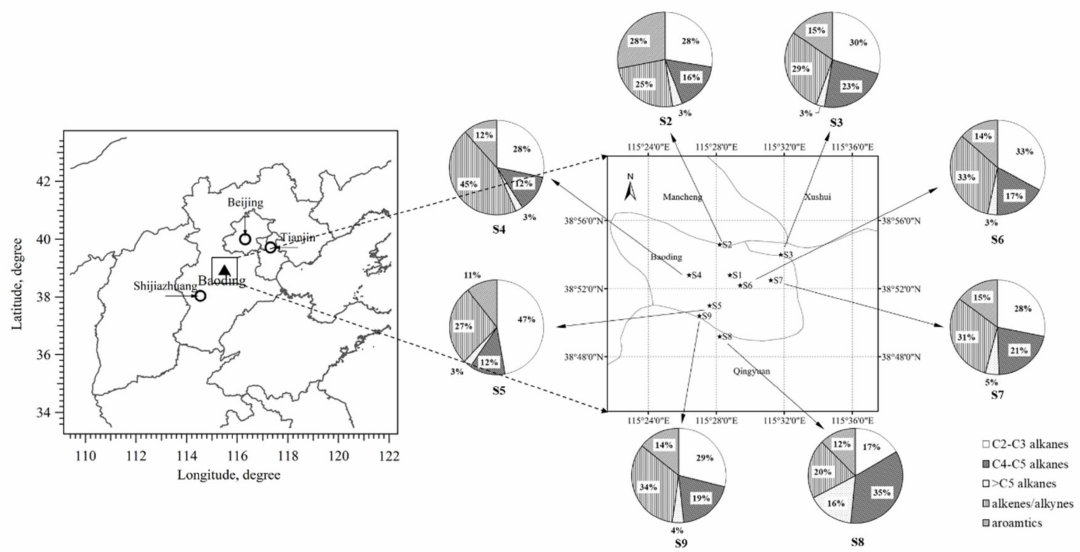
Figure 1. Locations of non-methane hydrocarbons (NMHCs) measurement sites in Baoding. The S1 site is for online measurement and the S2–S8 sites are for o ffl ine